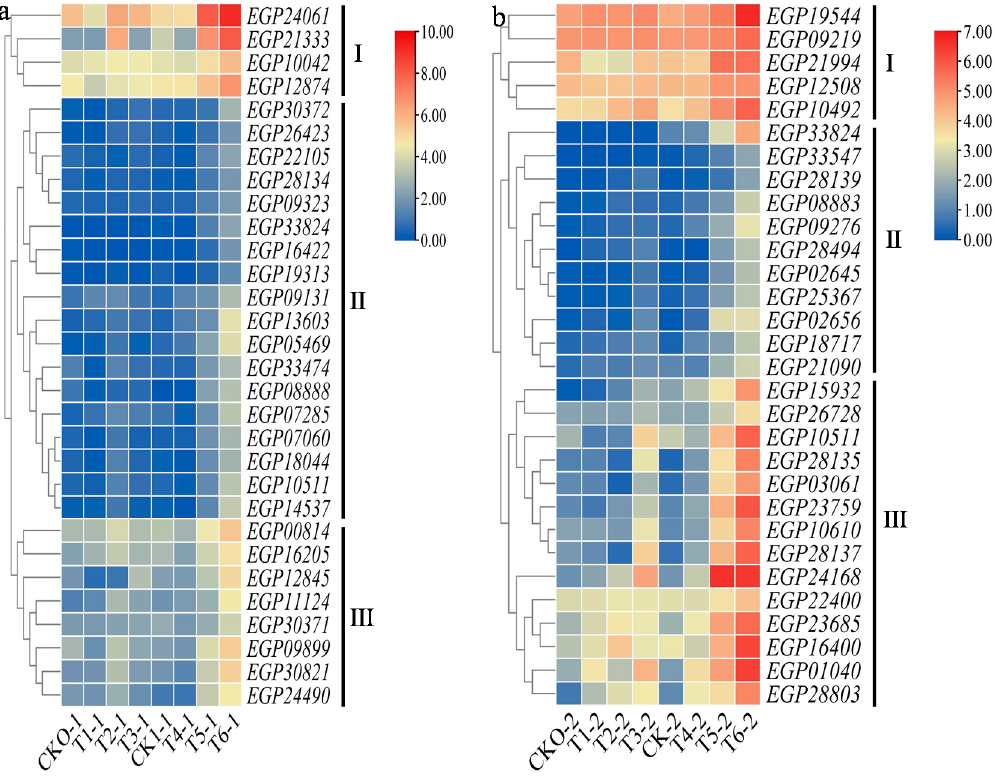
Figure 6. Heatmaps showing the top 30 expression pattern related to eggplant resistance to Ralstonia solanacearum infection in the root ( a ) and stem ( b ). The columns and rows in the heatmap represent genes and samples. The colour bars explain the scale used to indicate gene expression level; this scale represents the logarithm of FPKM values of gene expression, red to blue represent high to low expression.